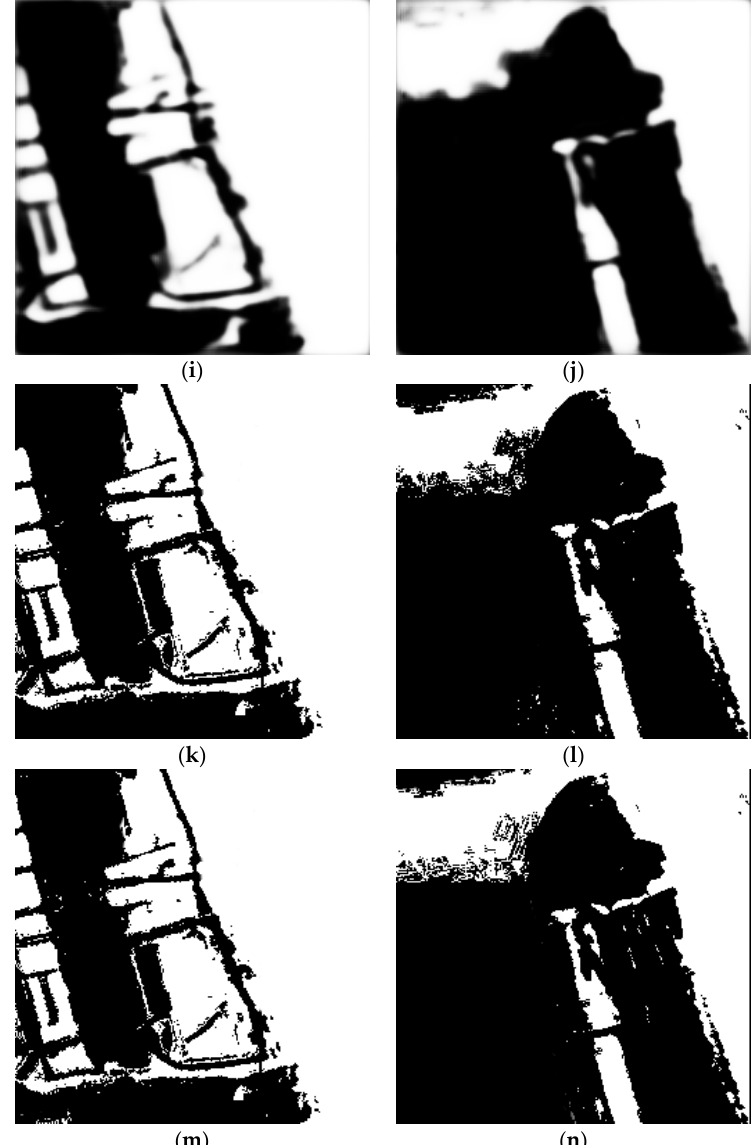
Figure 13. Comparison of different methods for water extraction in a tidal flat area. ( a ) Small water bodies; ( b ) water bodies with blurry boundaries; ( c , d ) NDWI; ( e , f ) SVM; ( g , h ) maximum likelihood classification; ( i , j ) U-Net; ( k , l ) YOLOv3; ( m , n )